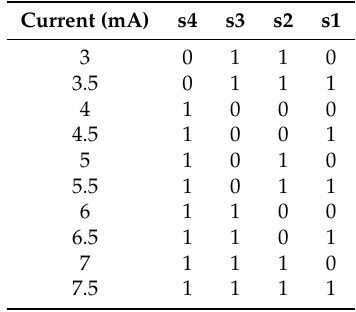
Table 4. Programmable switches to provide bias currents in the range from 3 to 7.5 mA, in steps of 0.5